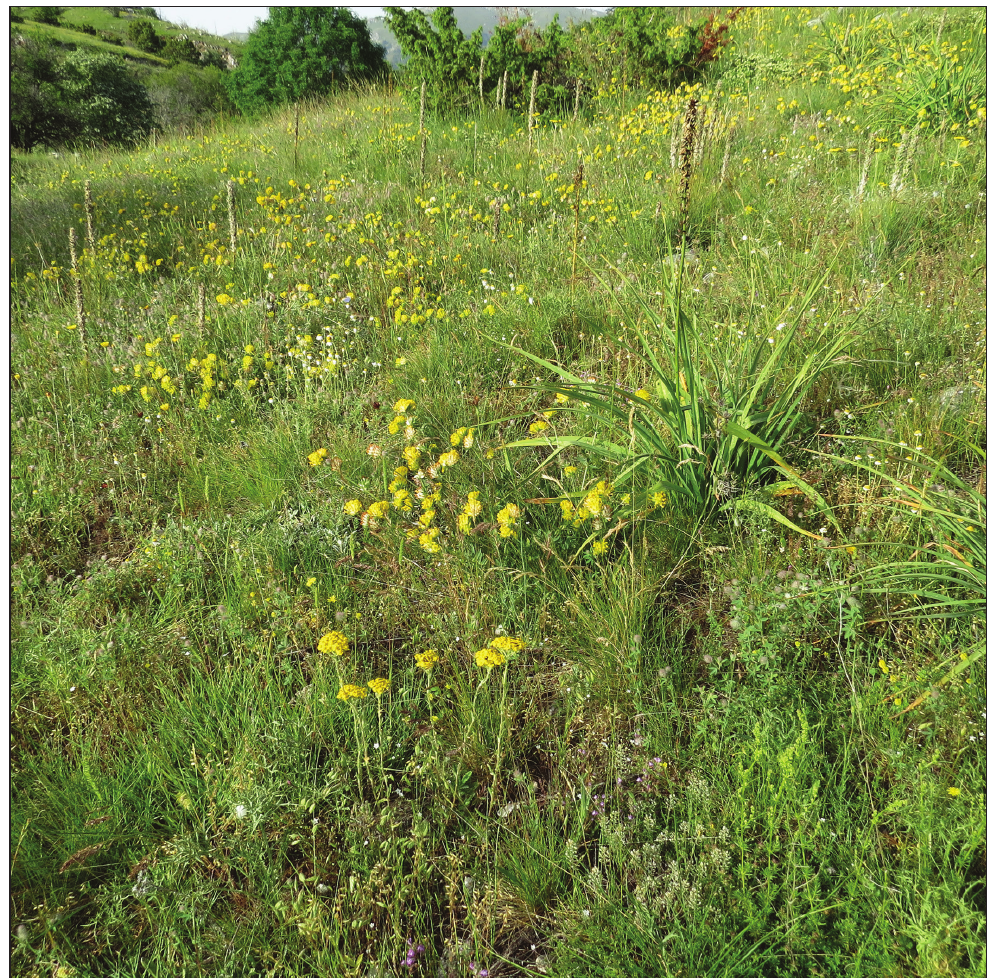
Figure 10. Habitat of Platyptilia galicicaensis sp. n. Macedonia, Galičica National Park.